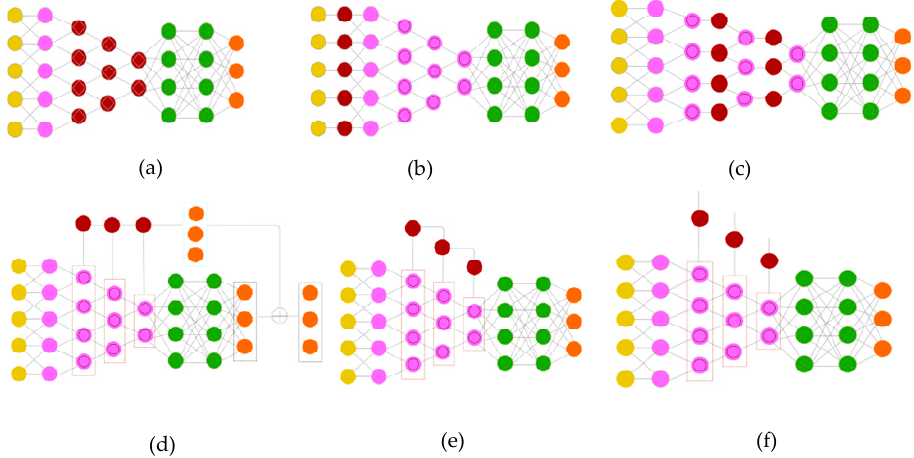
Figure 12. The architecture of the attention mechanism network. In ( a ) DCN attention pooling, the attention mechanism replaces the classic CNN [35] pooling mechanism. In ( b ) DCN attention input, the attention module is the filtering mask of the input data. In ( c ) DCN attention layer, the attention mechanism is applied between the convolutional layers. In ( d ) DCN attention prediction, the attention mechanism assists the model in the prediction process. In ( e ) DCN residual attention mechanism, the mechanism extracts information from the feature map and provides the remaining input connections at the next layer. In ( f ) DCN attention output, the attention mechanism captures significant activations of features of other architectures, or other instances of the same architecture.